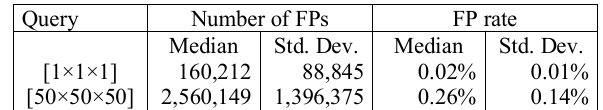
Table 2. False positive rates of the RowKey filtering step